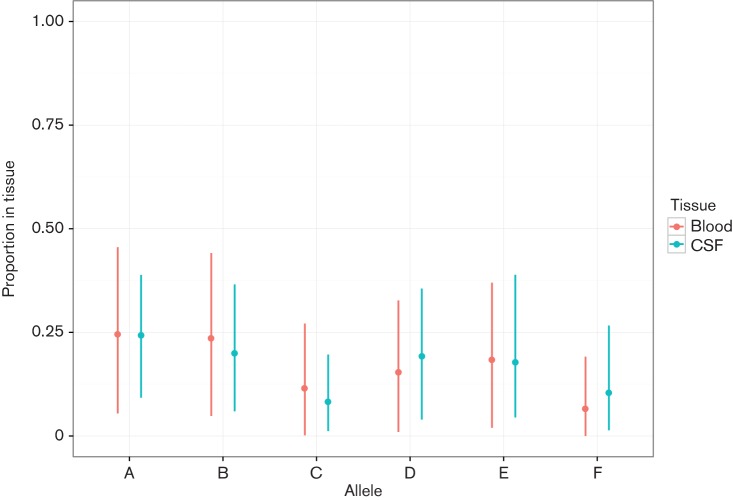
Mean and 95 % HPD for μc. This shows the proportion of each allele present in each of blood and CSF tissues pooling across all samples.